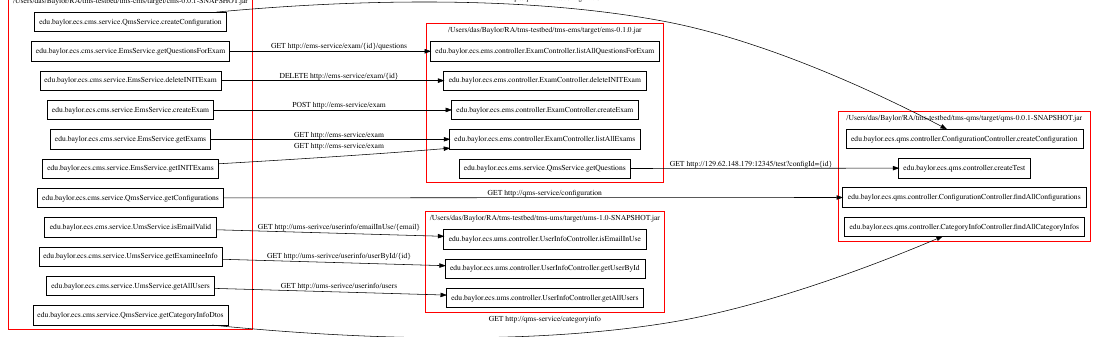
Figure 6. Inter microservice REST communications of TMS